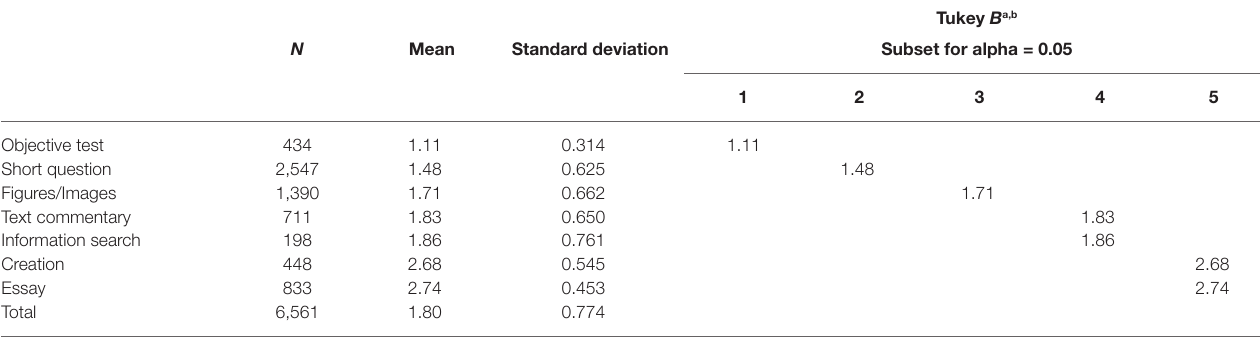
TABLE 6 | Cognitive level according to typology of activity and results of Tukey B test.